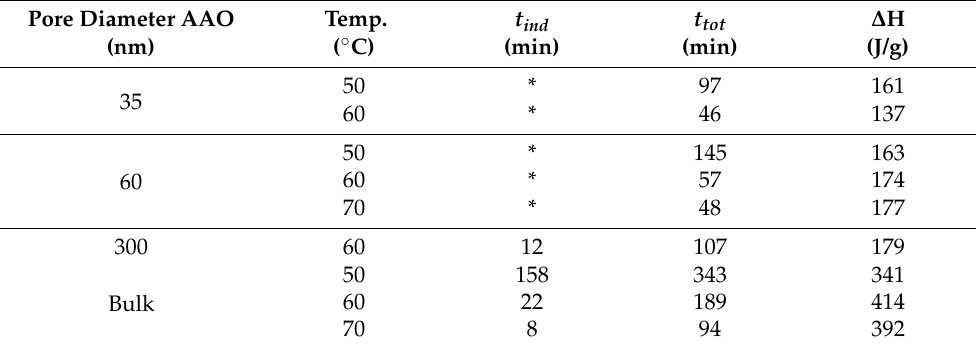
Table 2. Kinetic parameters of BMA free radical polymerization in confinement and bulk conditions at different temperatures determined, obtained by